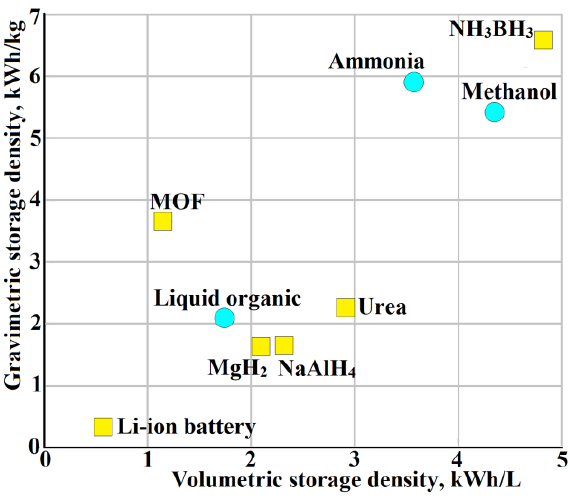
Figure 8. Gravimetric and volumetric energy storage densities for some solid (yellow squares) and liquid (blue circles) carriers.